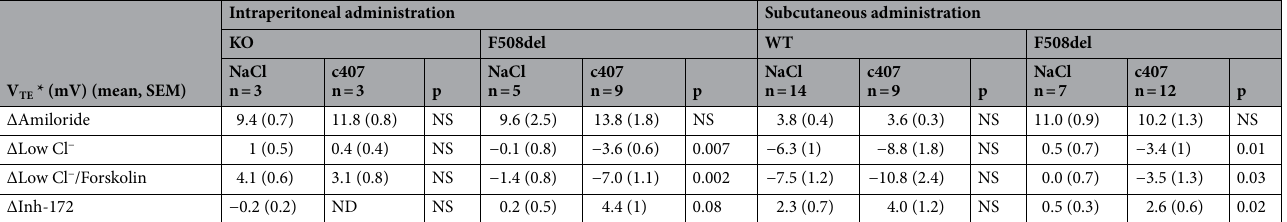
Table 2. Nasal potential difference after systemic administration of c407 or its vehicle by intraperitoneal route to KO Cftr tm1Unc (KO) and F508del Cftr tm1Eur (F508Del) mice or subcutaneous route to F508del Cftr tm1Eur and their wild type (WT) littermates. Univariate analysis by Wilcoxon